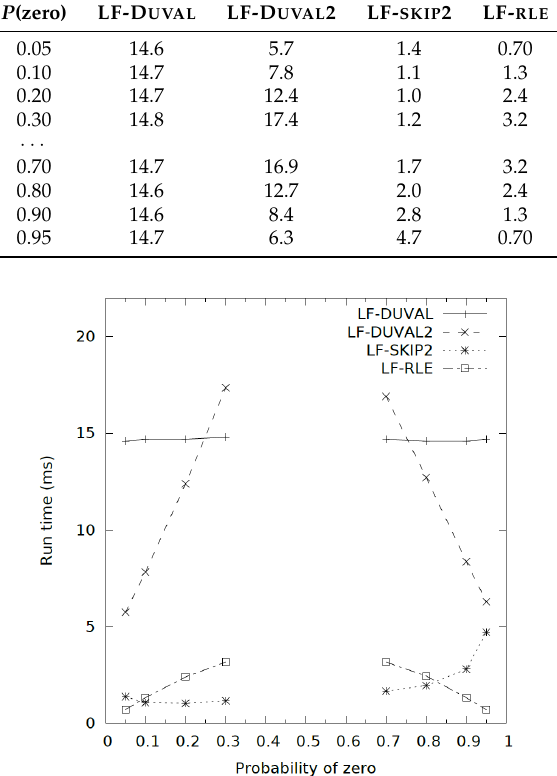
Table 3. Run times in milliseconds on random binary sequences (5 MB) with a skew distribution. P (zero)